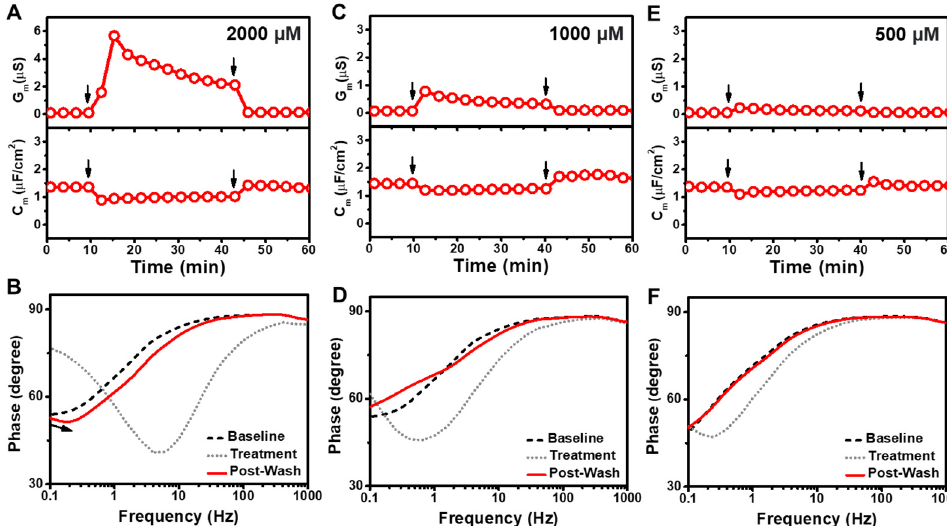
Figure 3. ( A ) Time-resolved conductance (G m ) and capacitance (C m ) shifts upon 2000 µM LA addition to the tBLM platform. The arrows indicate compound addition at t = 10 min and buffer washing at t = 40 min, respectively. ( B ) Bode plots for 2000 µM LA addition to the tBLM platform, whereby baseline, treatment, and post-washing reflect the initial measurement signal, signal after compound addition, and signal after buffer washing, respectively. Corresponding data for ( C , D ) 1000 µM LA and ( E , F ) 500 µM LA addition to the tBLM platform.